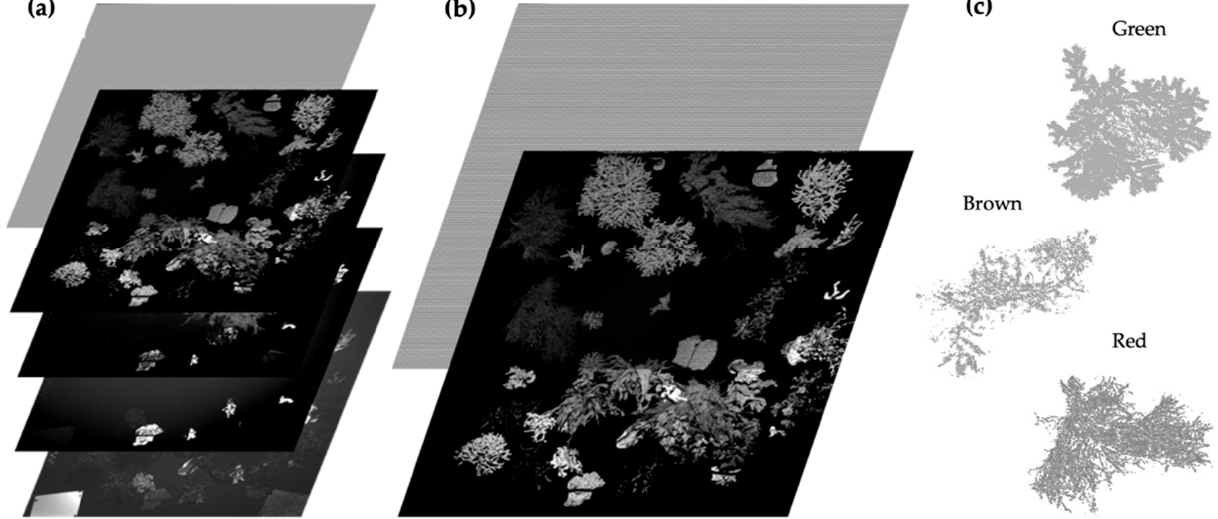
Figure 3. Representation of mixed species macroalgae and coral multispectral response stacked data set arrangement ( a ) bottom to top: 490 nm excitation, with 490 nm, 520 nm, 580 nm, and 685 nm emission + pixel grid; ( b ) detailed 685 nm emission from 490 nm excitation + pixel grid; ( c ) isolated pixels belonging to three types of macroalgae after segmentation (i.e., segmentation of